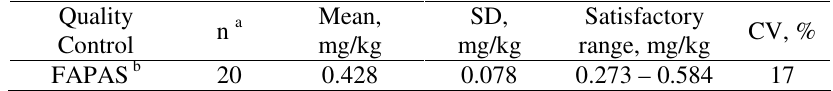
Table 2. Inter-day precision data for lead